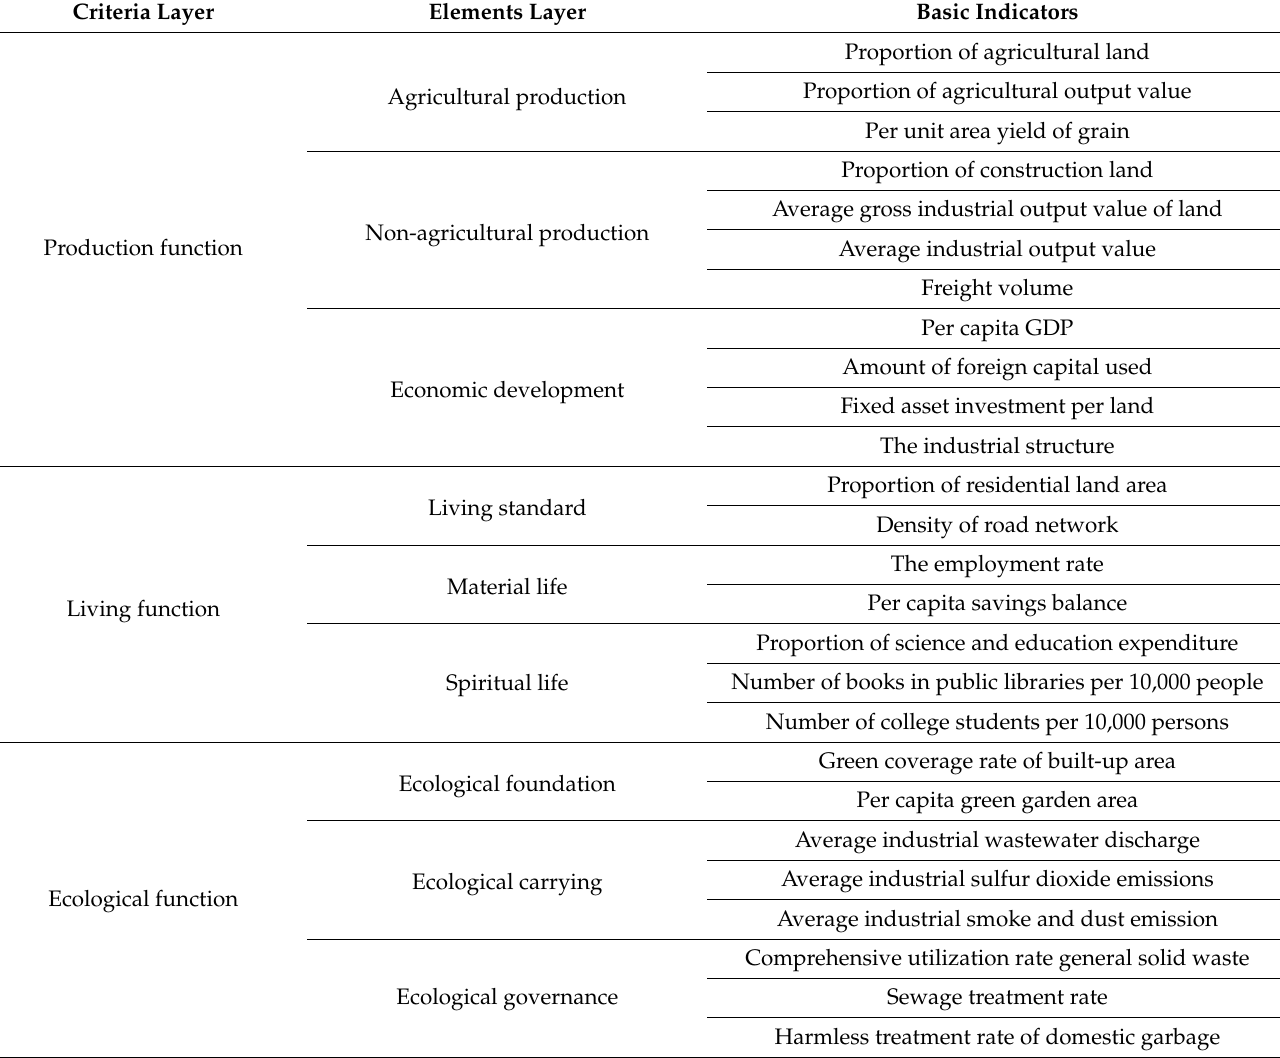
Table 1. Functional coordination evaluation index system of